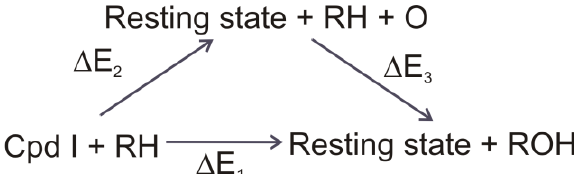
Figure 12. Thermodynamic cycle showing the relationship between ΔE enthalpy) and ΔE